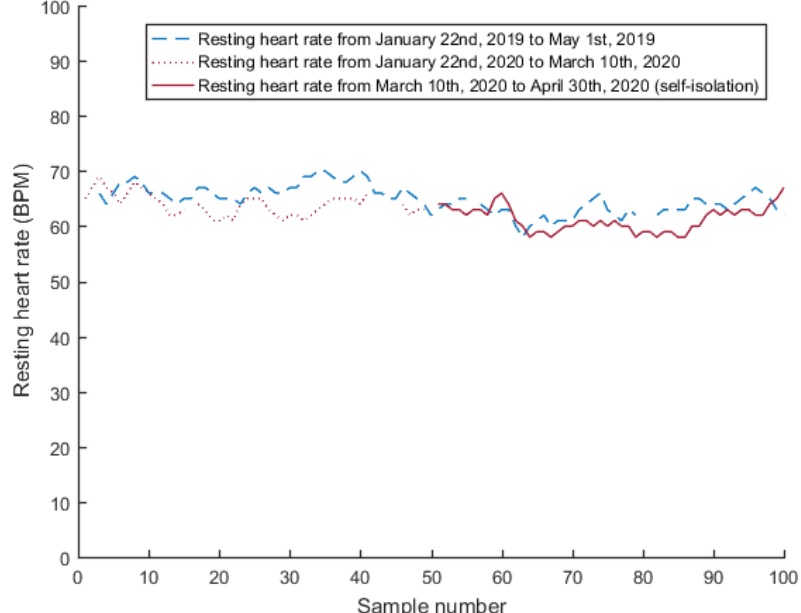
Figure 5. Resting heart rates (RHR) in the two analyzed intervals for Subject 4.